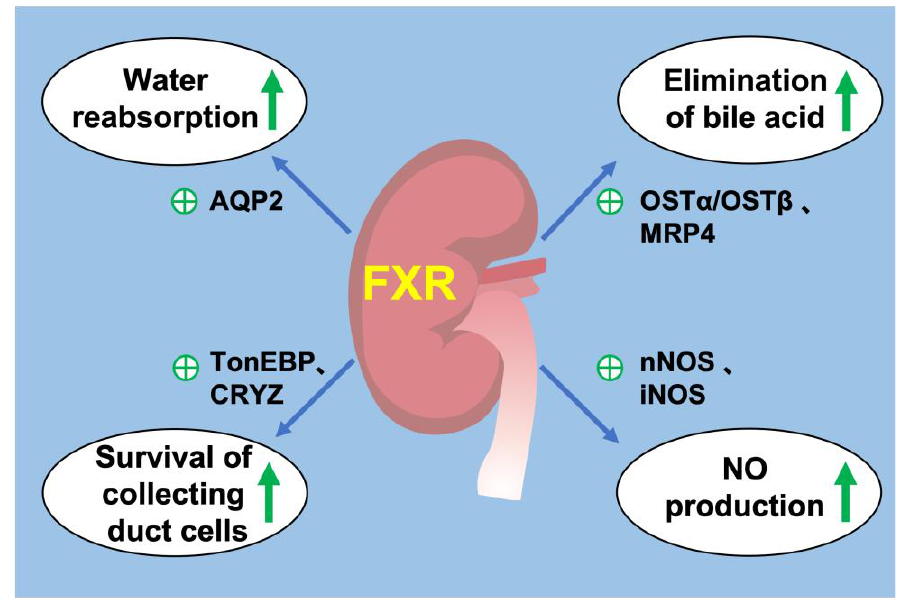
Figure 2. FXR and renal physiology. (1) FXR activation promotes water reabsorption in renal collecting duct by upregulating AQP2 expression. (2) FXR promotes the elimination of bile acids from the